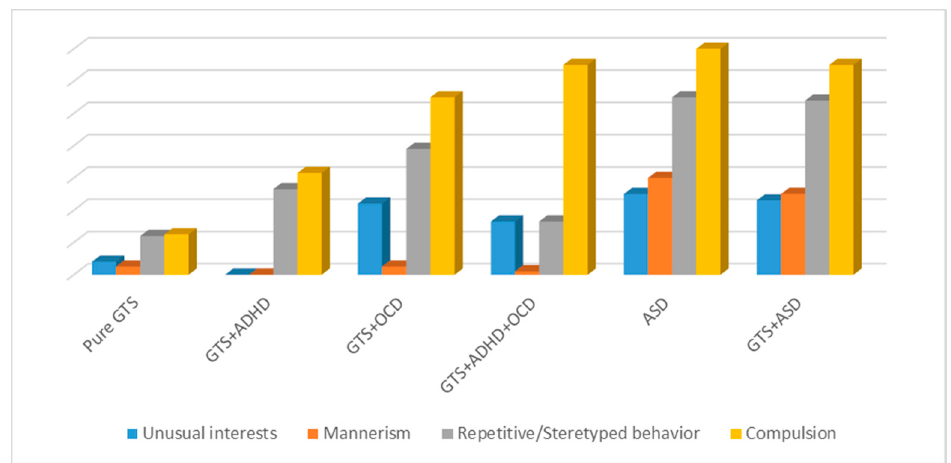
Figure 5. ADI-R, Restricted and Repetitive Behaviors (C Scale): comparison between clinical sub-phenotypes. Table 5. ADI Restricted and repetitive behaviors (C): comparison between GTS clinical sub-phenotypes.